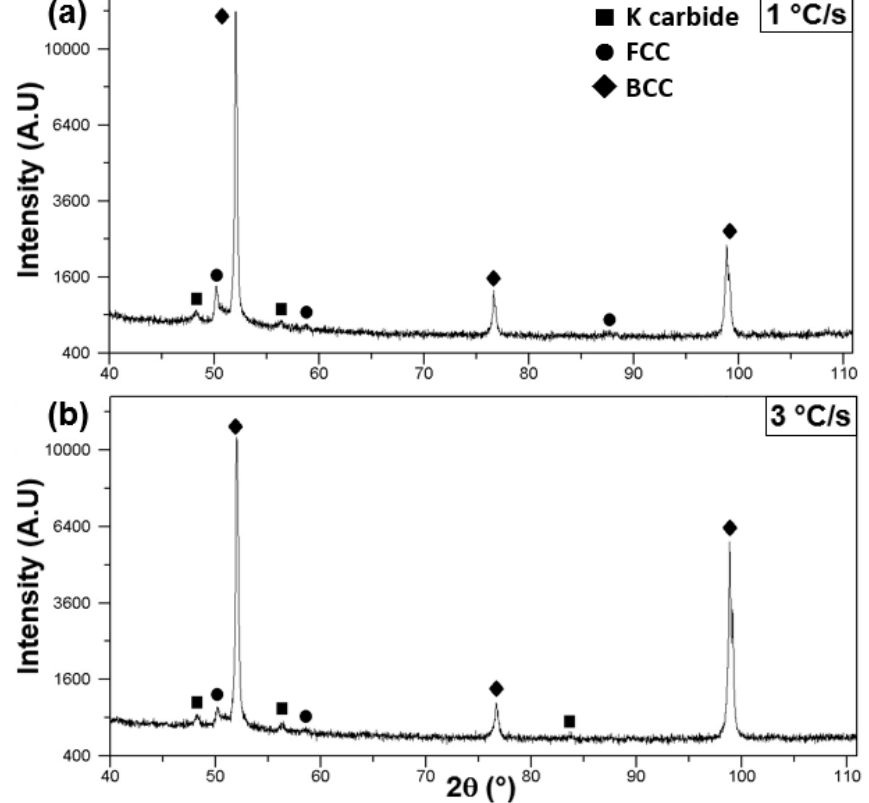
Figure 3. Diffractograms for the dilatometry samples submitted to low cooling rates: ( a ) 1 °C/s and ( b ) 3 °C/s (radiation: Co k α ).